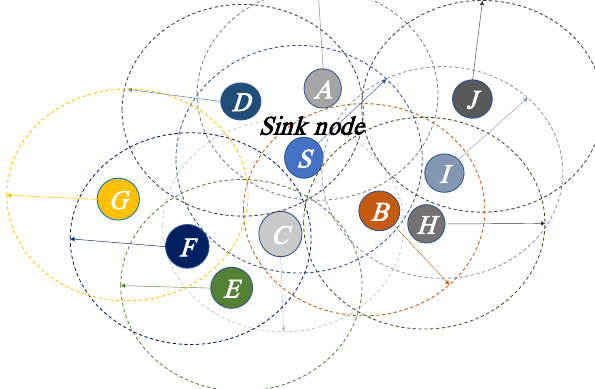
Figure 2. Sensor network example.